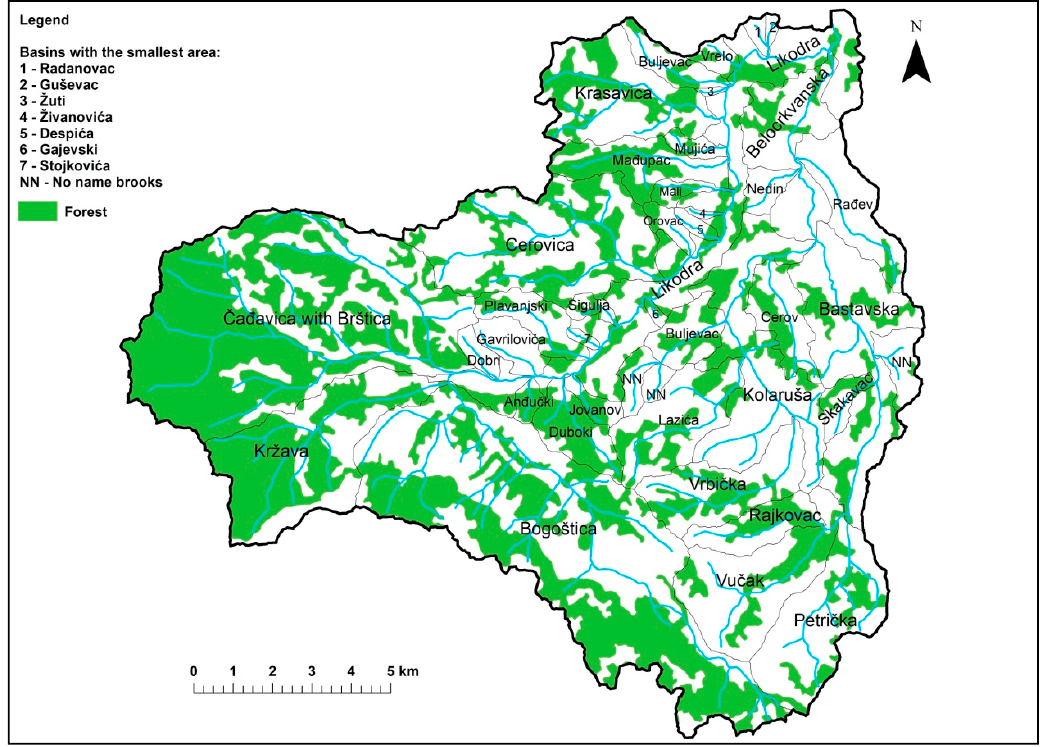
Figure 6. Forest areas in theLikodrariver basin.